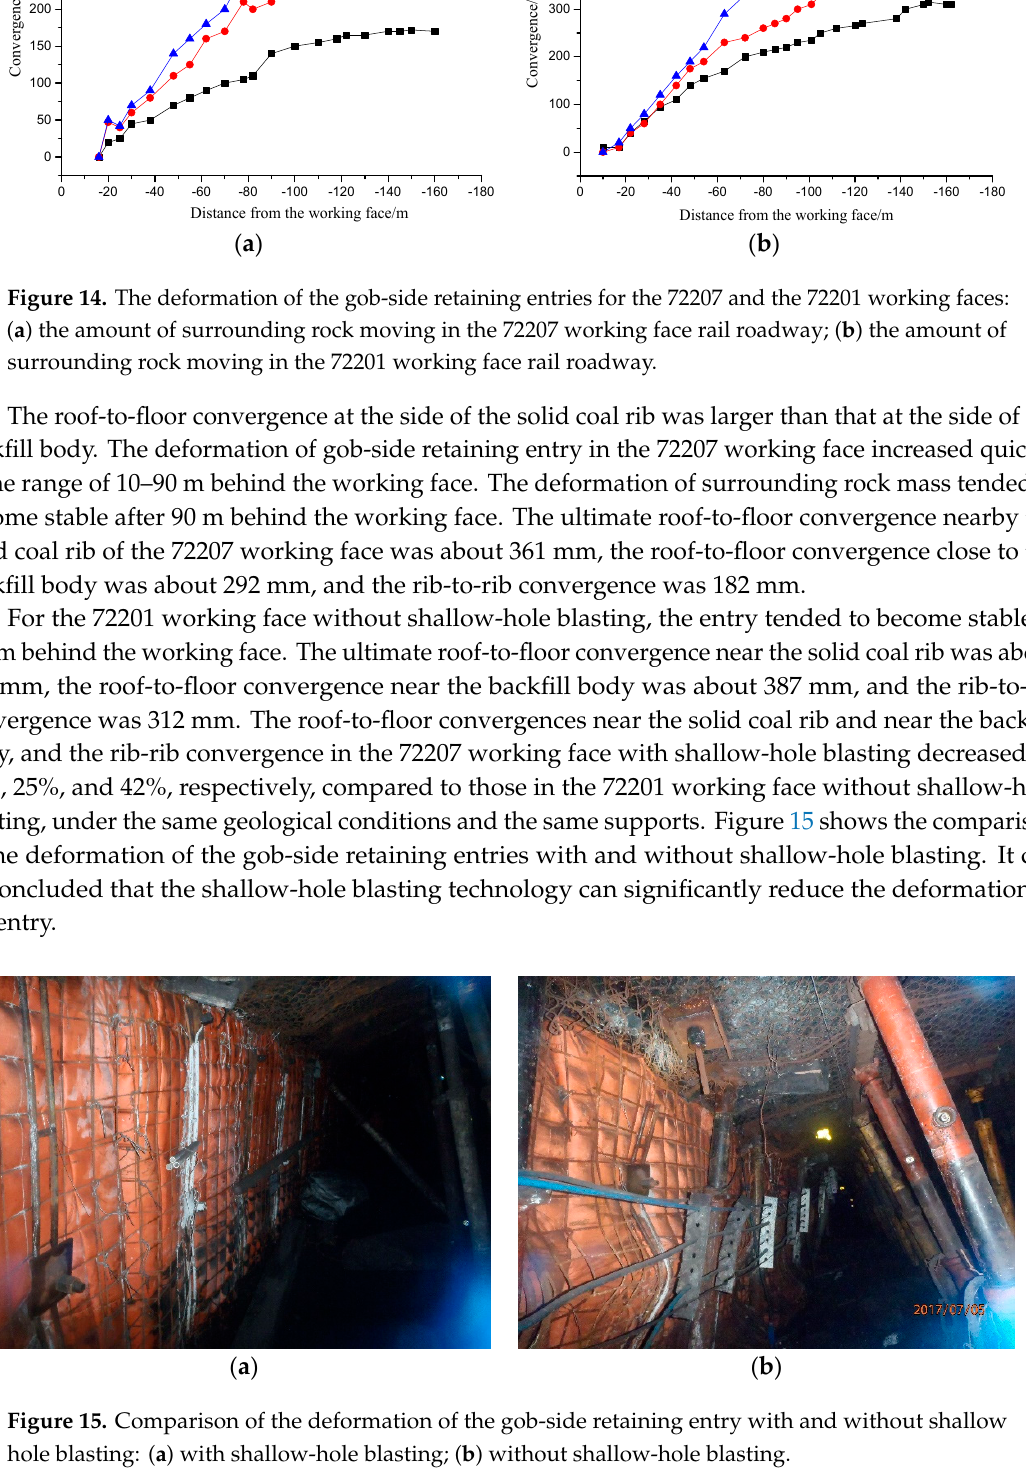
1000 Figure 13. Diagram of shallow-hole blasting hole.